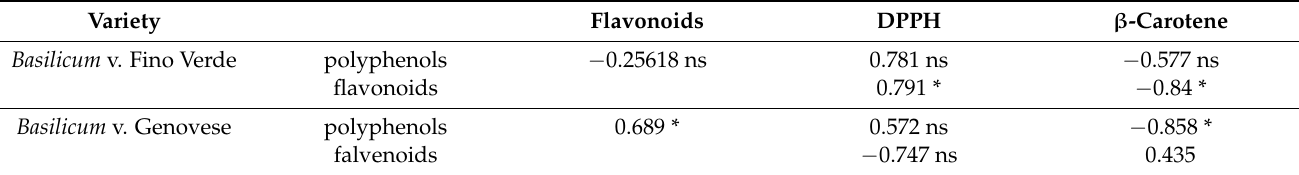
Table 2. Correlation test between all parameters measured for the two varieties of O. basilicum